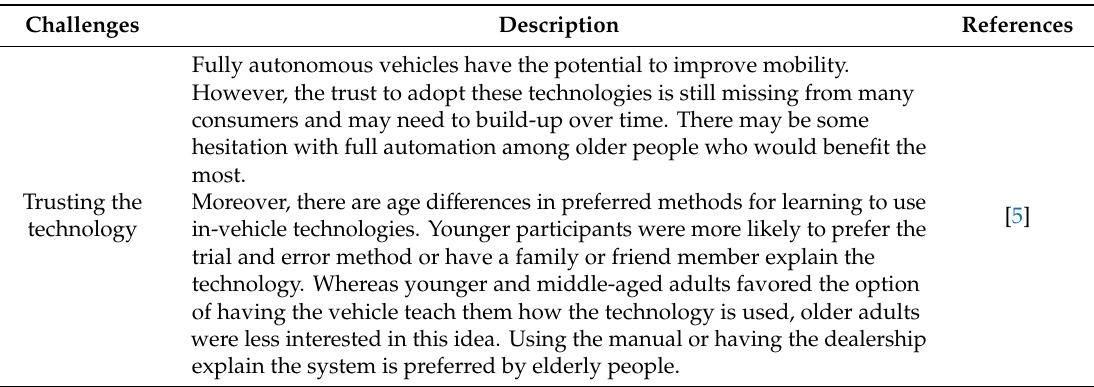
Table 4. Challenges of